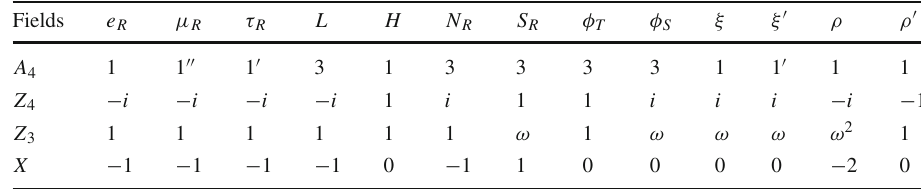
Table 1 The particle content and their charge assignments for an A 4 realization of the linear seesaw mechanism